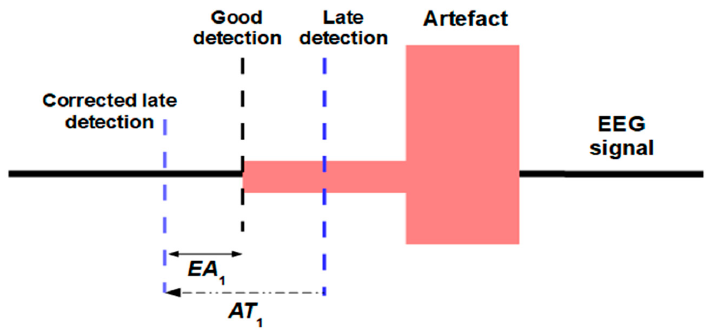
Figure 5. An artefact and two types of detection.